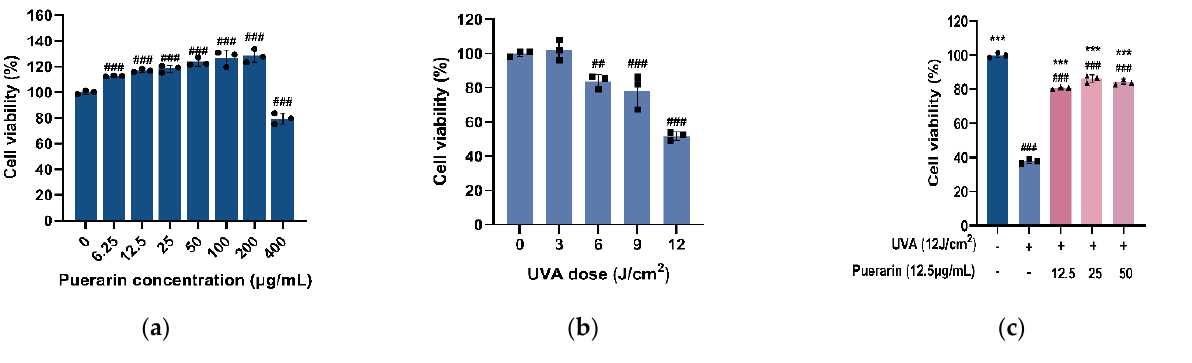
Figure 1. Effects of puerarin on UVA-induced cytotoxicity in human skin fibroblasts (HSF): ( a ) Toxicity of different concentrations of puerarin on HSF; ( b ) Toxicity of different doses of UVA on HSF; ( c ) Preventative effects of puerarin on cytotoxicity in UVA-irradiated HSF. ## p < 0.01, ### p < 0.001 as compared to the control group; *** p < 0.001 as compared to the damage model group; Values do not have a common mark ( # , *) when p > 0.05, ( n = 3).